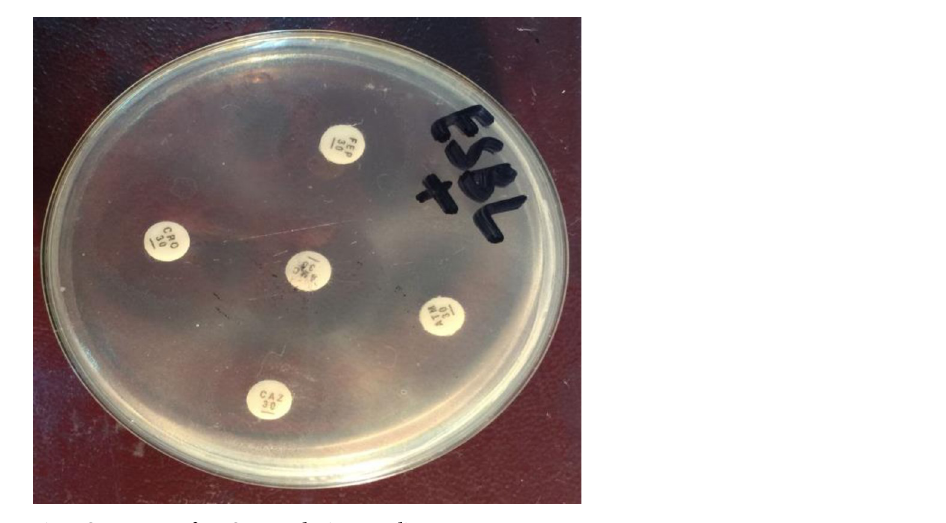
Fig 4. Synergy test for ESBL producing E . coli .